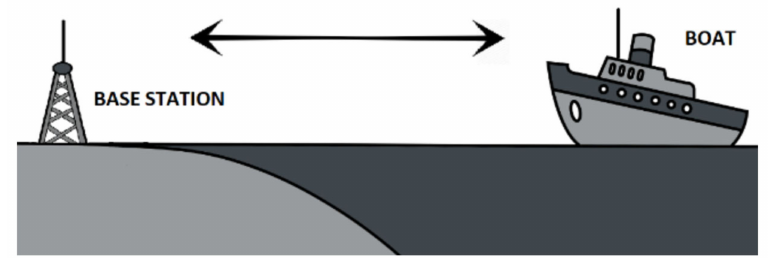
Figure 1. First communication scenario representing the communication between a boat and a base